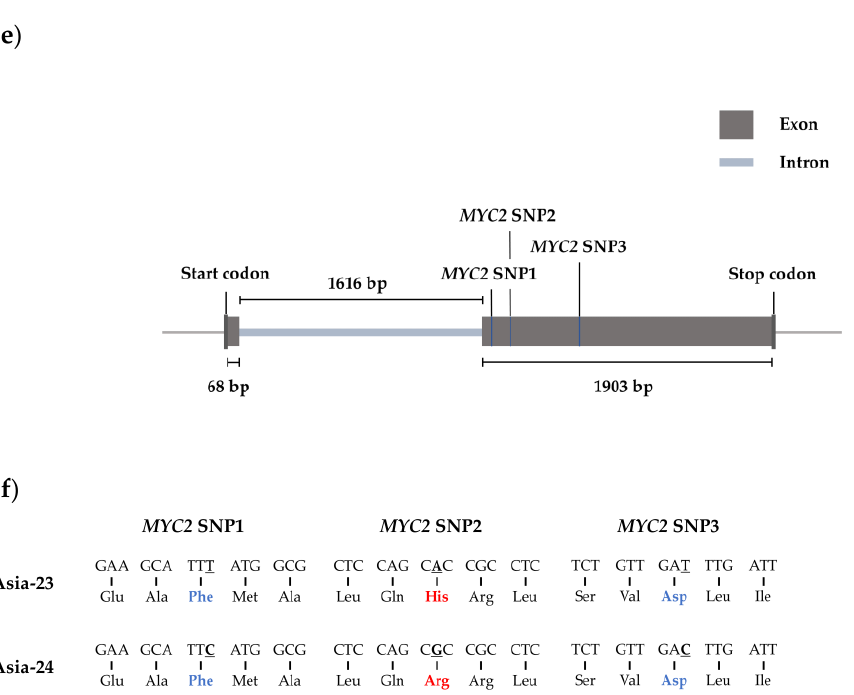
Figure 6. Confirmation of selected gene sequences from gDNA. ( a ) Structure of JAR1 gene and the information of each region. ( b ) SNPs and amino acid sequences of JAR1 gene between Asia-23 and Asia-24. ( c ) Structure of COI1 gene and the information of each region. ( d ) SNPs and amino acid sequences of COI1 gene between Asia-23 and Asia-24. ( e ) Structure of MYC2 gene and the information of each region. ( f ) SNPs and amino acid sequences of MYC2 gene between Asia-23 and Asia-24. Bold and underlined: SNP, Red: Synonymous mutations, Blue: Non-synonymous mutations.